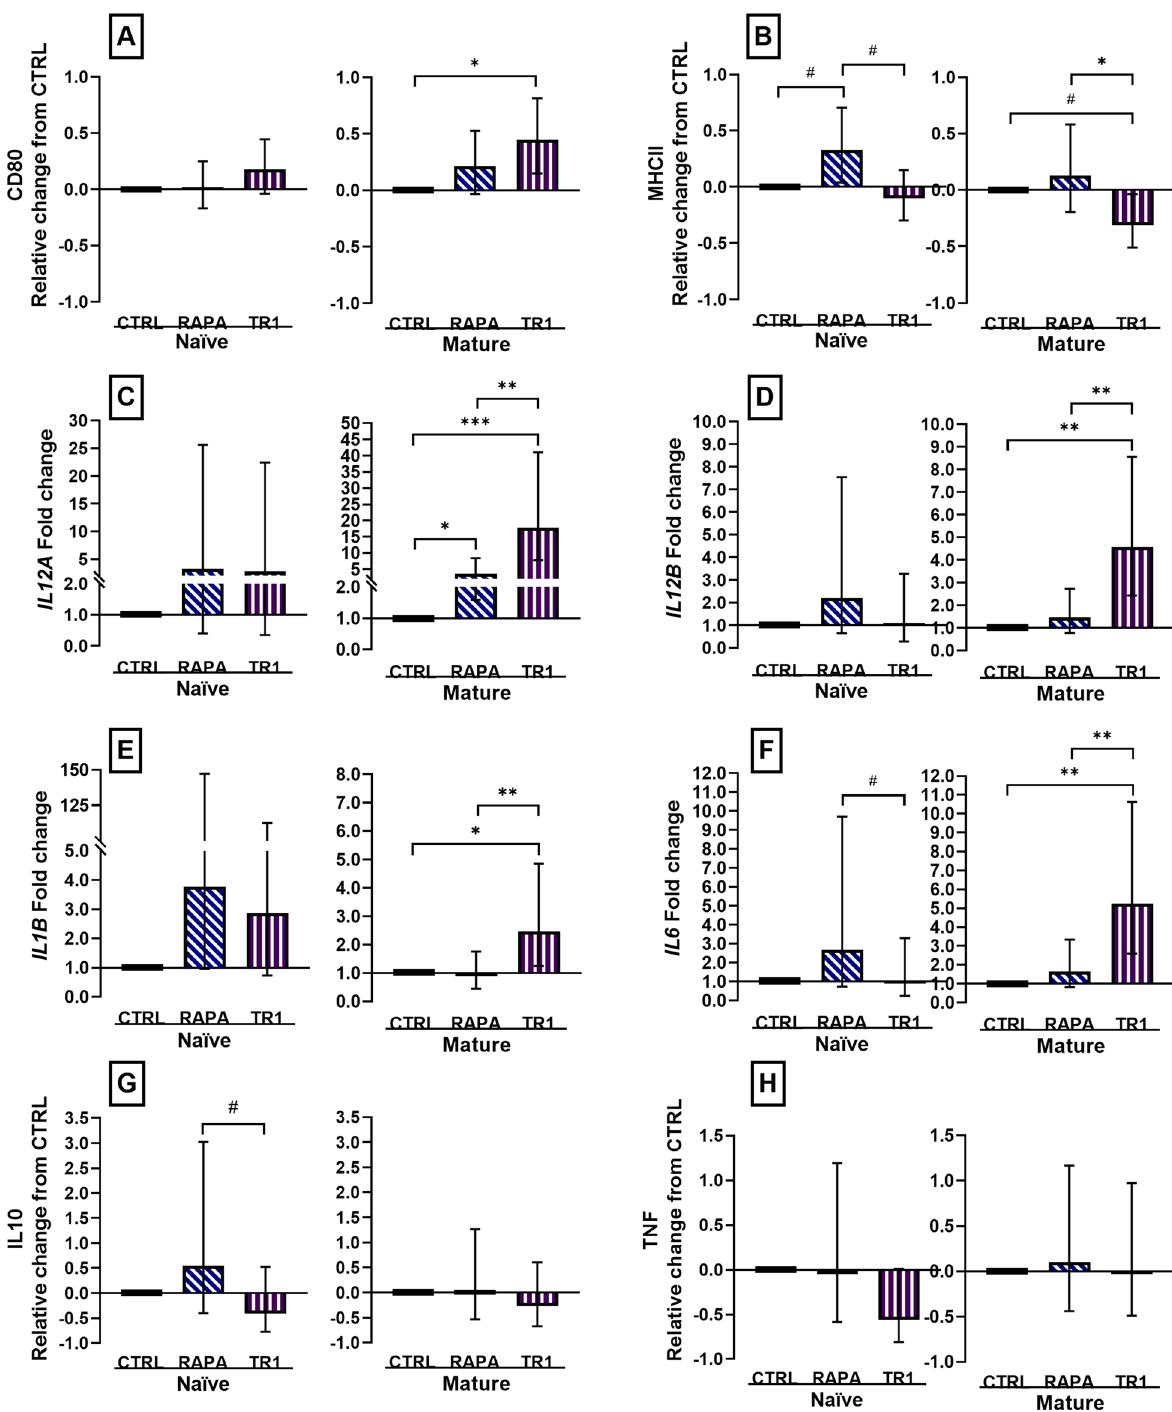
Figure 5. Changes in surface maker expression, mRNA abundance, and cytokine production in moDC after differentiation for 7 days with 20 ng/mL CSF2 and IL4 and concurrently treated with vehicle (CTRL), or inhibitors rapamycin (RAPA) or Torin-1 (TR1) at 100 nM during the last 4 days of differentiation. Naïve moDC (Naïve) were matured with 100 ng/mL LPS (Mature) for 16 h to characterize surface markers CD80 ( A ) and MHCII ( B ) and measure cytokine production of IL10 ( G ) and TNF ( H ) protein, and for 4 h to quantify mRNA abundance of IL12A, IL12B, IL1B , and IL6 ( C – F ). Data were expressed relative to CTRL and presented as relative change from CTRL in naïve and mature moDC for surface marker expression and cytokine production. mRNA abundance was expressed as the fold change from CTRL in naïve and mature moDC. Data from cell isolation of 12 cows are presented as geometric mean and backtransformed 95% confidence interval. ANOVA tests between CTRL and inhibitors, and between inhibitors are presented with Bonferroni-adjustment for multiple comparisons: P ≤ 0.10 ( # ), P ≤ 0.05 (*), P ≤ 0.01 (**), P ≤ 0.0001